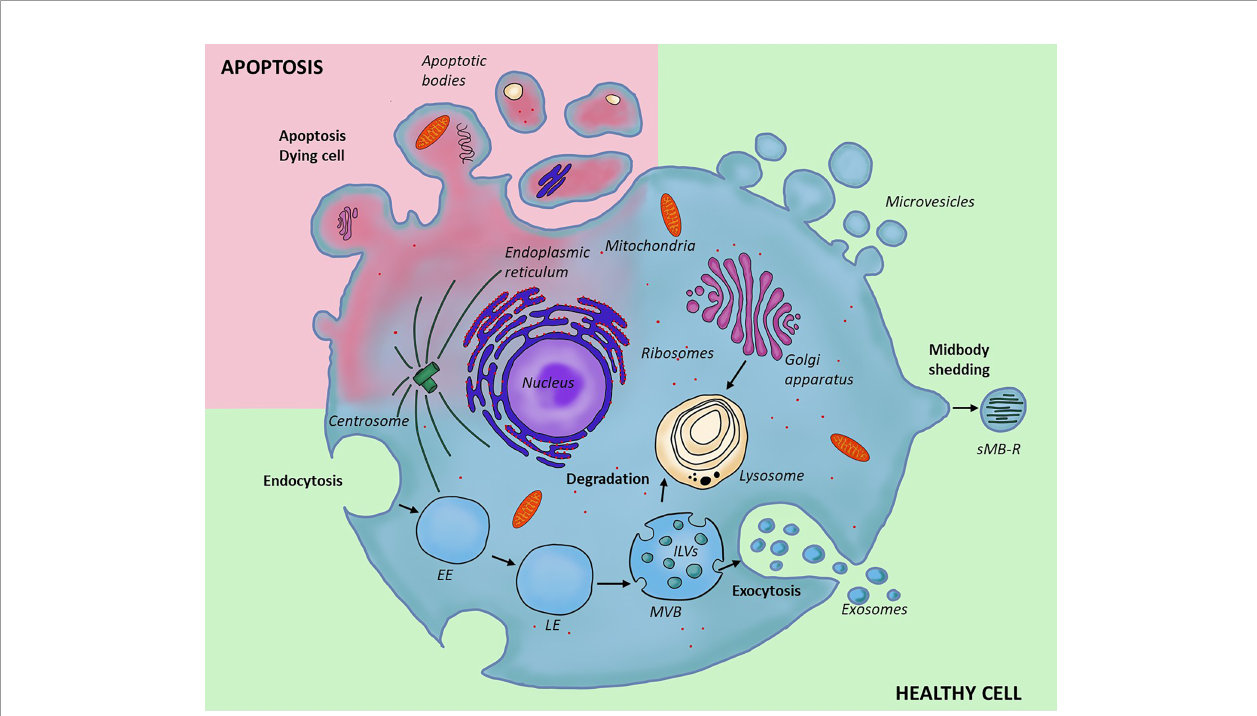
FIGURE 1 | Different types and biogenesis of extracellular vesicles. Two types of EVs form through outward invagination of the plasma membrane; microvesicles and apoptotic bodies. The apoptotic bodies are larger and form in the context of programmed cell death; they enclose organelles removed from the cell during degradation, while microvesicles are produced by a healthy cell; their content is similar to that of the cytoplasm. Secreted midbody remnant is also secreted from the plasma membrane, but contain residual secreted midbody remnants are following cell division. In contrast to this, exosomes form through a distinct cellular pathway and within the endocytic system where inward budding of late endosome leads to the formation of a multivesicular body containing multiple intraluminal vesicles. The content of multivesicular bodies is either digested after fusion with lysosome (degradative pathway) or released into the extracellular space (secretory pathway). EE, early endosome; LE, late endosome; MVB, multivesicular body; ILVs, intraluminal vesicles; sMB-R, secreted midbody